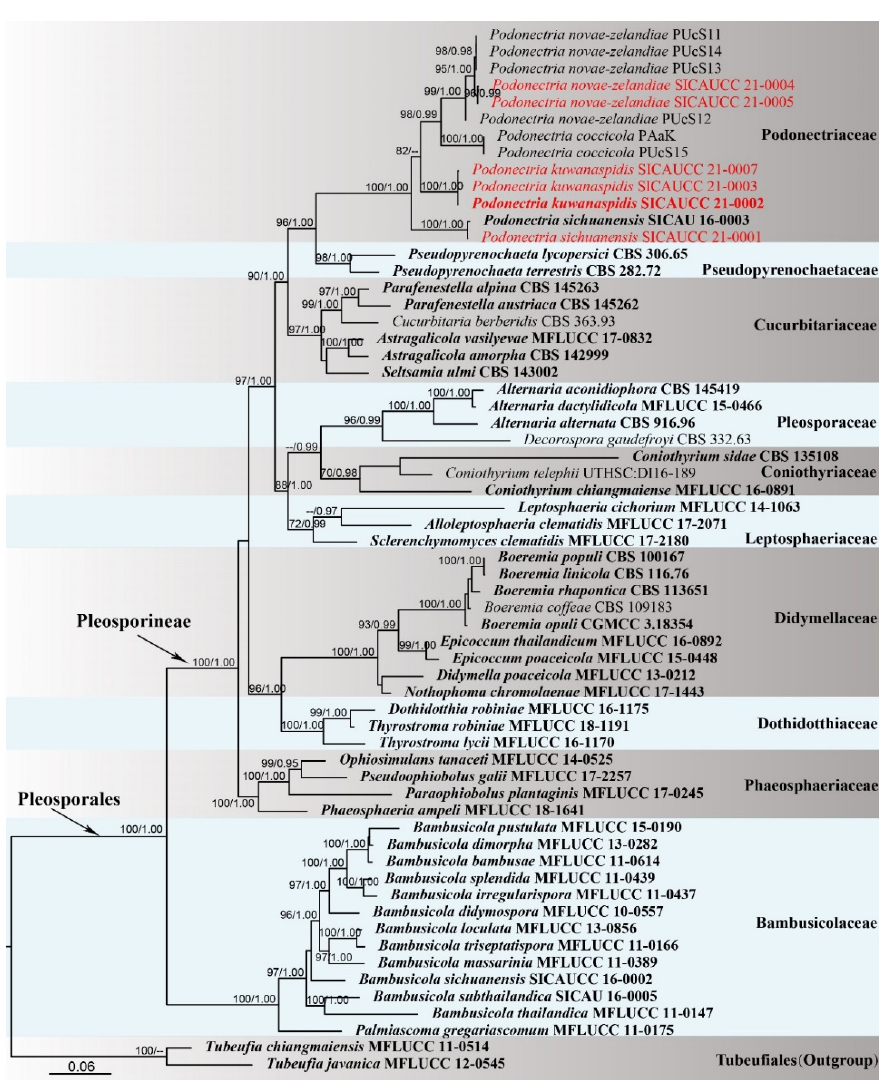
Figure 1. Phylogram generated from RAxML analysis based on ITS, LSU, SSU, tef1- α , and rpb2 Scheme 70. and Bayesian posterior probabilities (BYPP, right) equal to or greater than 0.95 are indicated at the nodes respectively. The sequences from ex-type strains are in bold. The newly generated sequence is in red bold.